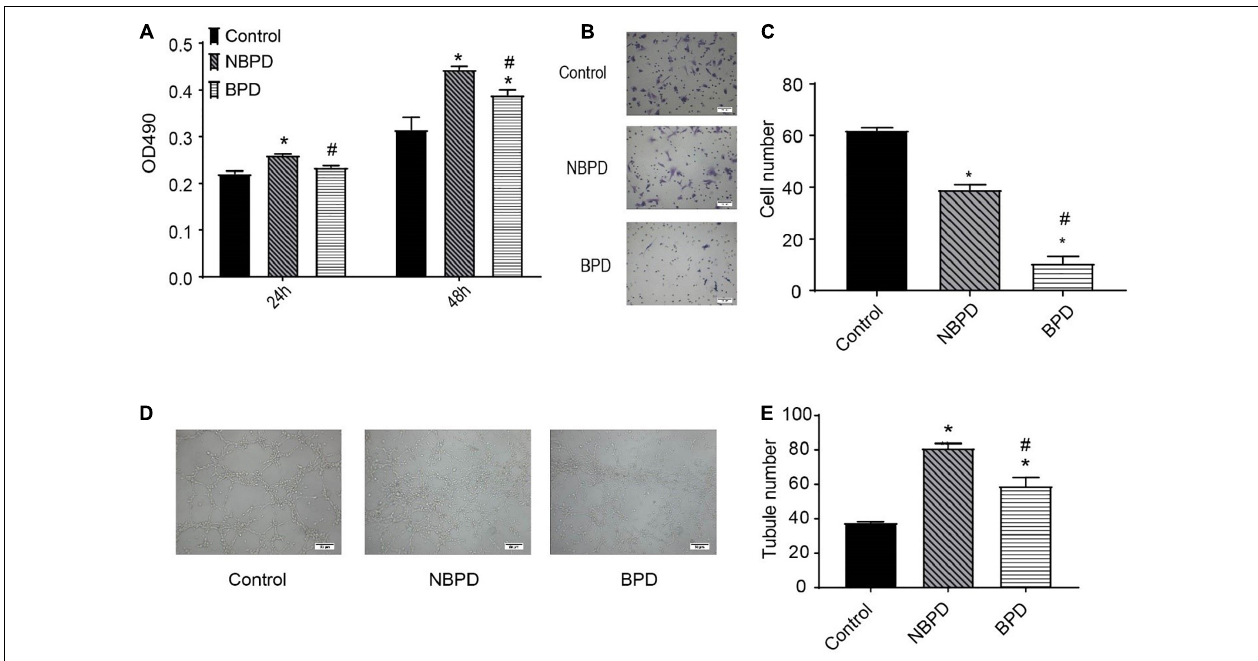
FIGURE 2 | Effects of umbilical cord blood-derived exosomes on endothelial proliferation, migration, and tube formation. (A) HUVECs were treated with exosomes (50 µ g/ml) from NBPD and BPD infants or vehicle for 24 h and 48 h, respectively. Cell proliferation was determined using CCK-8. (B,C) HUVECs were treated as indicated for 16 h, and number of migrated cells was determined by transwell. * , # P < 0.05 versus control and NBPD group, respectively. N = 3. Scale bar = 30 µ m. (D,E) HUVECs were treated with exosomes or vehicle as indicated. Tube formation was determined at 6 h after treatments (scale bar = 50 µ m). *, # P < 0.05 versus control and NBPD, respectively. n =